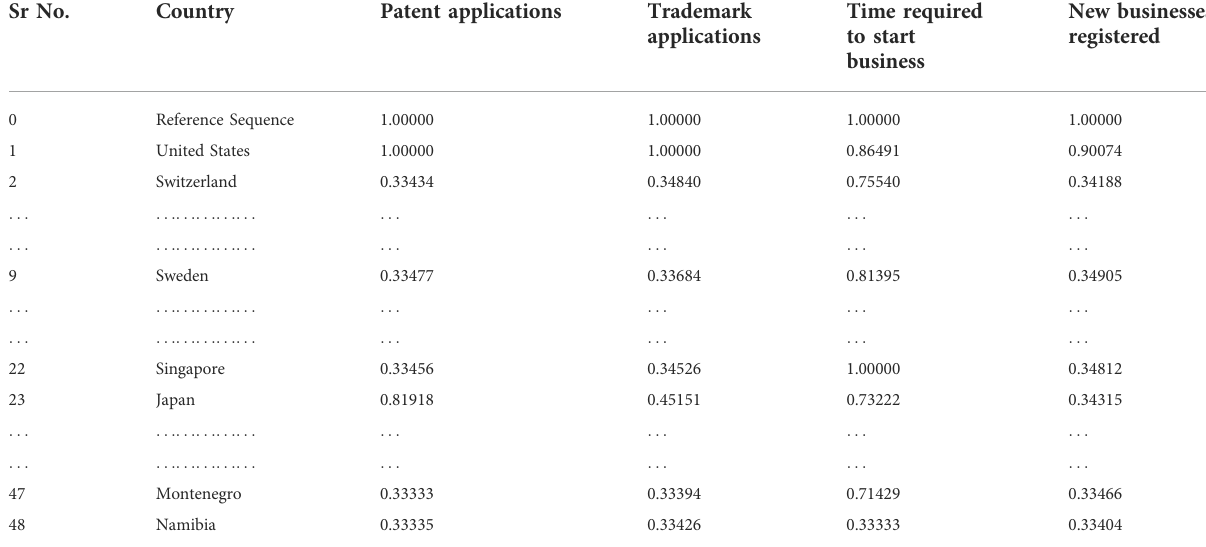
TABLE 6 Grey relational coef fi cient.